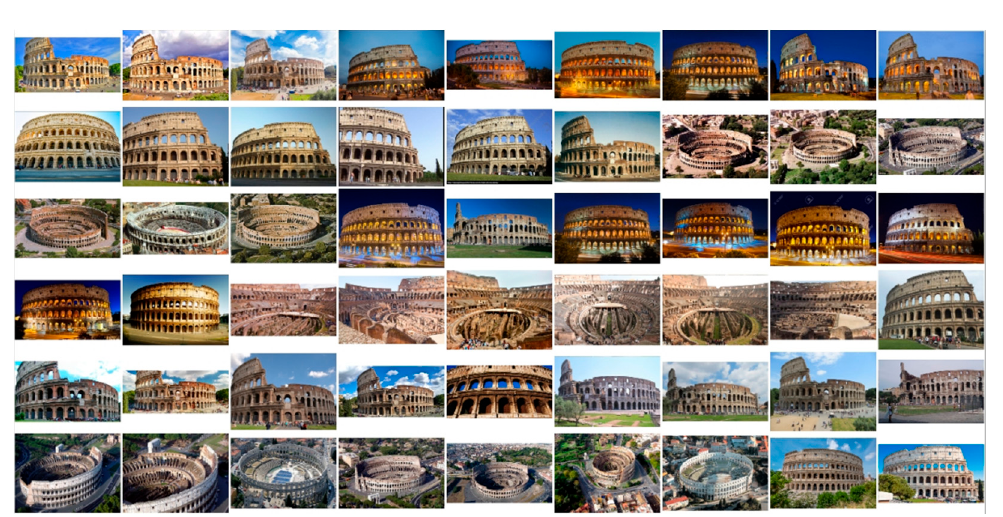
Figure 7. Matching results for the Colosseum dataset.